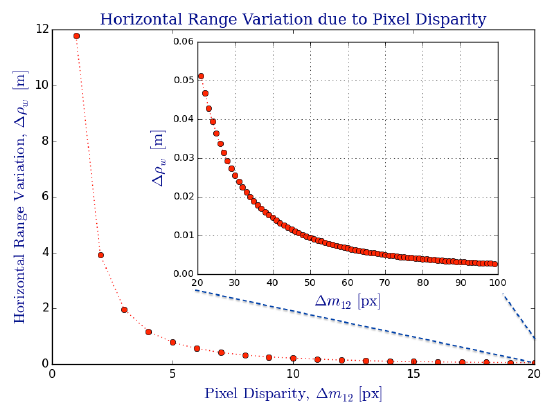
Figure 17. Variation of horizontal range, ∆ ρ w , due to change in pixel disparity ∆ m 12 on the omnidirectional image, [ I ] . There exists a “nonlinear & inverse” relation between the change in depth from triangulation ( ∆ ρ w ) and the number of disparity pixels ( ∆ m 12 ) available from the omnistereo image pair ( [ I 1 ] , [ I 2 ] ) , which are exclusive subspaces of [ I ]